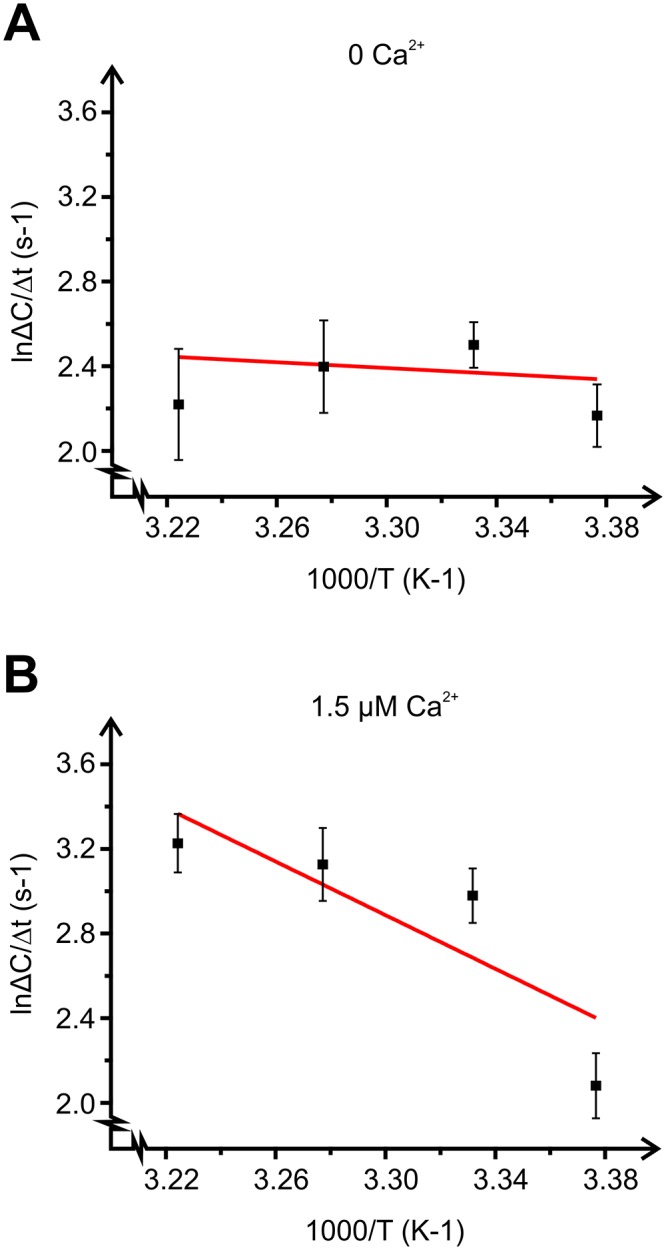
Arrhenius plots presenting the effect of Ca2+ on the rate of cAMP-triggered exocytosis.Absolute values of ΔC/Δt at t = 2 min plotted against the inverse of temperature (T) in the absence (A) and presence (B) of cytosolic Ca2+. The curve represents a linear least-squares fit to the equation lnk = lnA—EA/RT. EA is the energy of activation, k is the change in ΔC/Δt upon a temperature change, A is the pre-exponential factor. R represents the gas constant and T the absolute temperature as usual. The negative slope of the curve gives activation energies of 5.7 kJ mol-1 (A) and 53 kJ mol-1 (B).